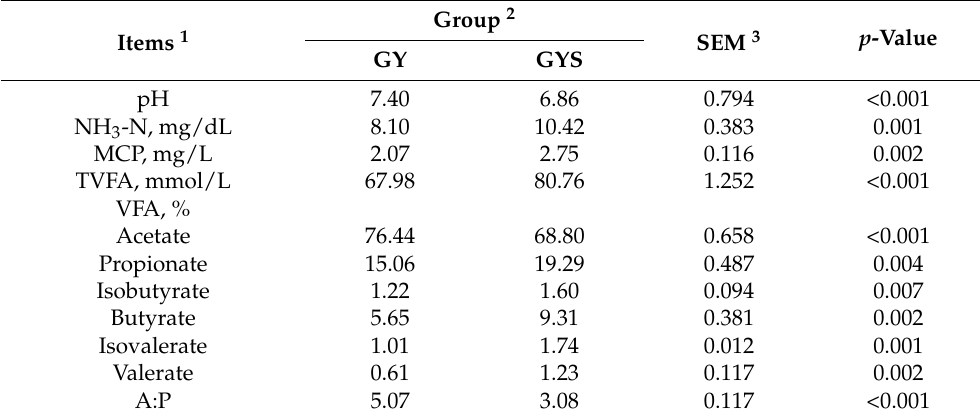
Table 3. Effect of concentrate supplementation on rumen fermentation parameters of grazing yaks during the warm season.